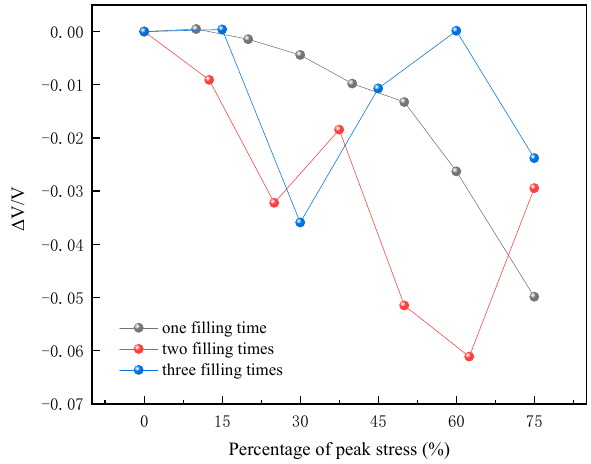
Figure 13. Coda wave velocity variation rate of LCTB with different filling times.